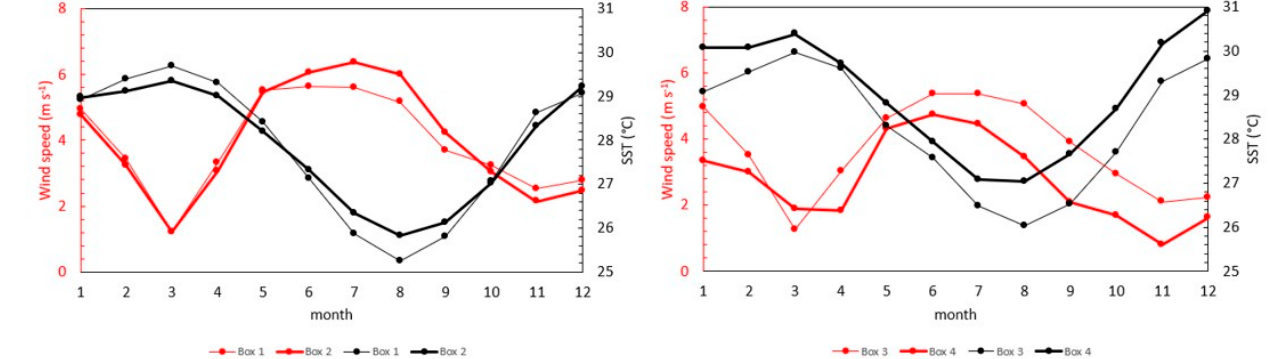
Figure 7. The monthly climatology of wind speed and sea surface temperature (SST) within the boxes in Figure 3.